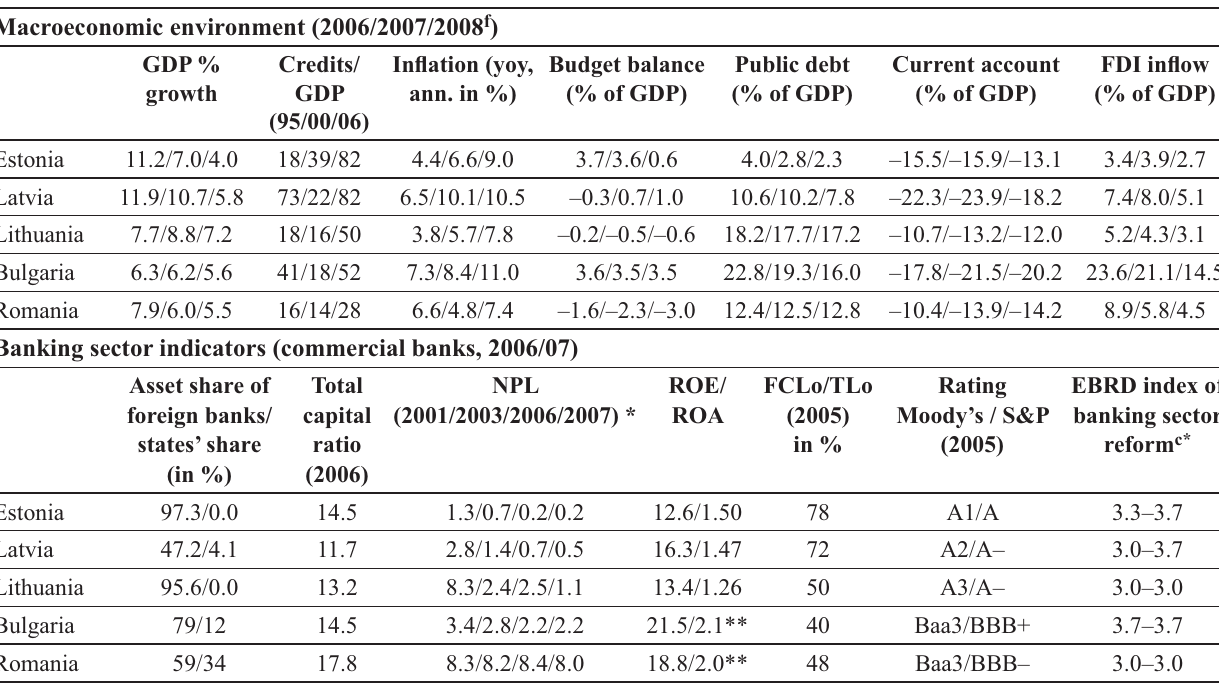
Table 1. Macroeconomic and banking sector indicators for the Baltic States, Bulgaria and